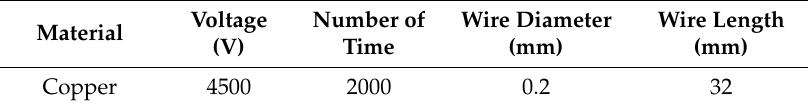
Table 1. Mixing conditions of copper nano powder.